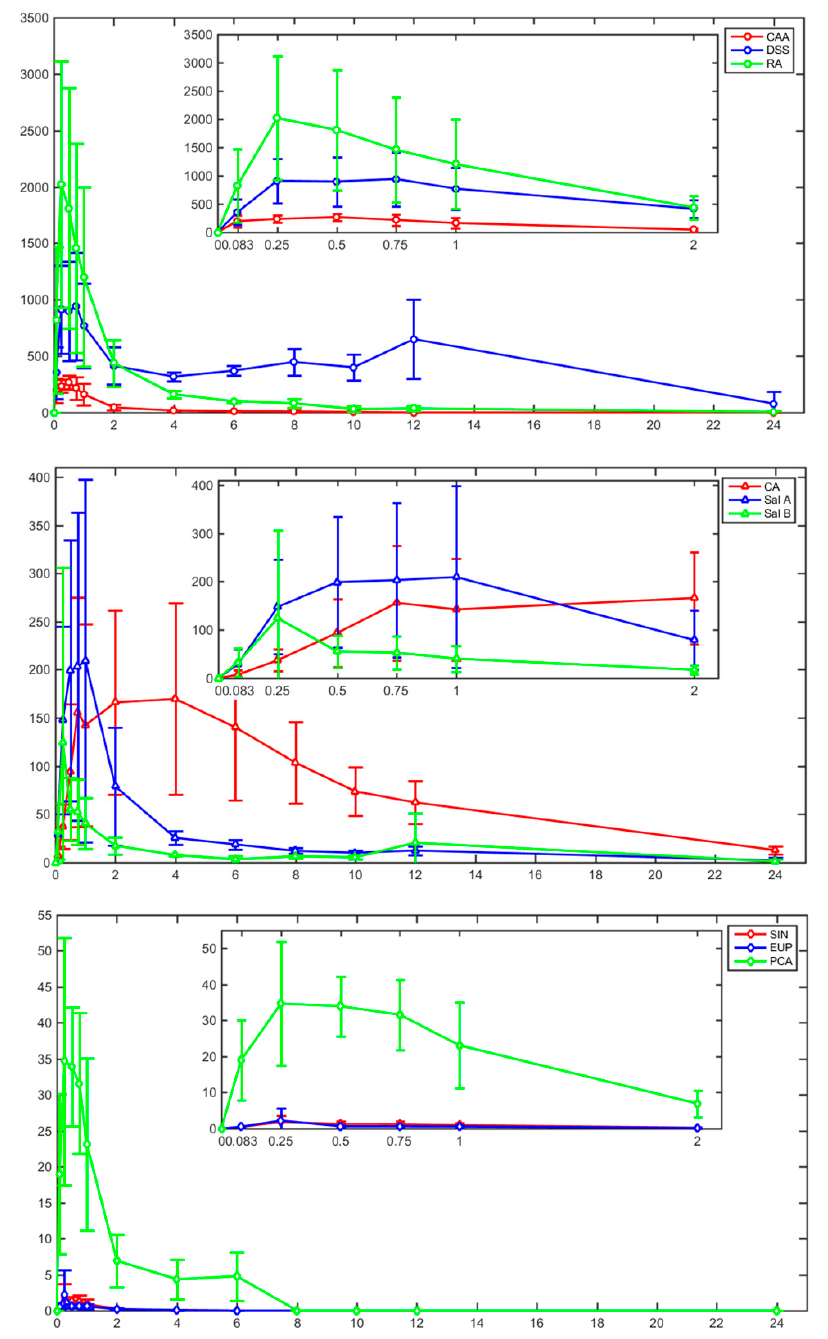
Figure 2. Mean plasma concentration-time profiles of the nine analytes in rats after oral administration ( n = 6).